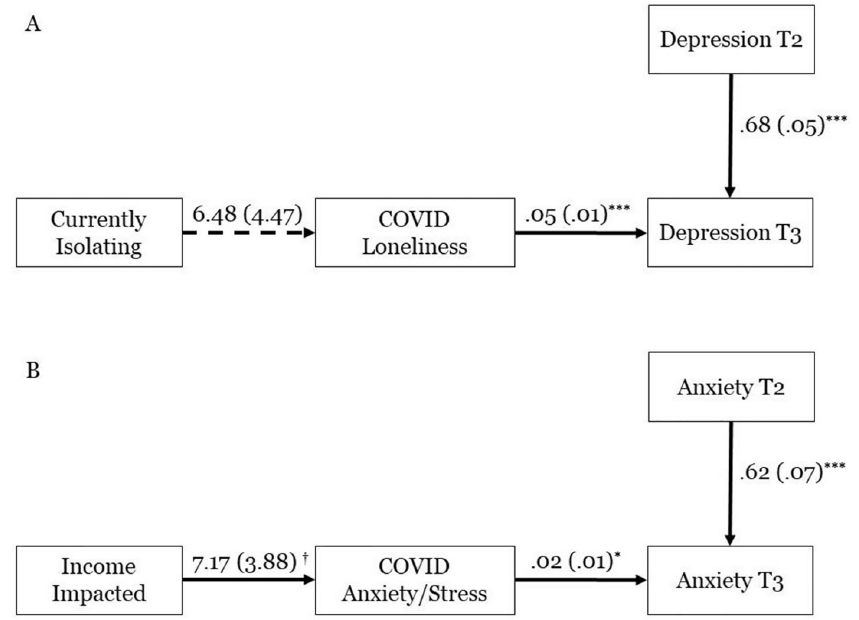
Fig 3. a and b. Structural equation model where COVID-19 loneliness/stress predicts depression/anxiety beyond baseline. ��� p < .001, � p � .05, † p < .10. T2 –Data collection at Time 2, April 15–22, 2019. T3 –Data collection at Time 3, April 15–20, 2020. The above models were bad fits for the data (e.g., CFI = .000) and were therefore rejected.